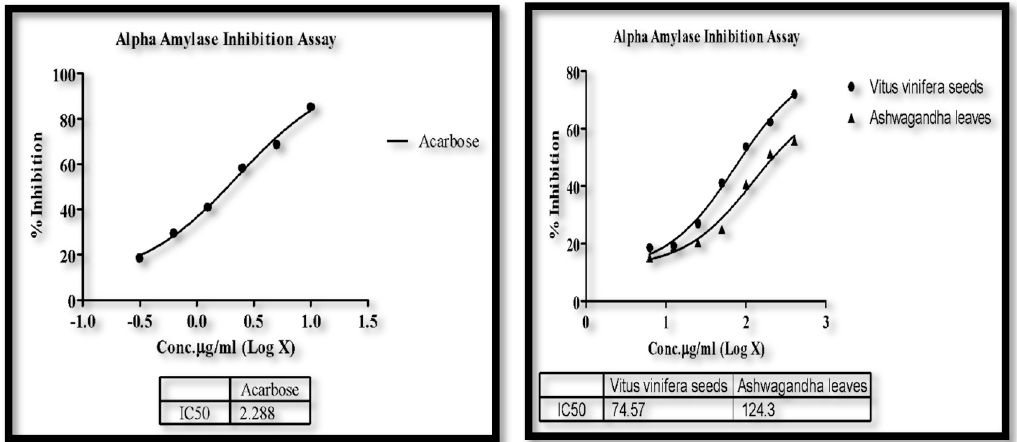
Figure 3. Linear graph of V. vinifera , W.somnifera and standard acarbose and plant.